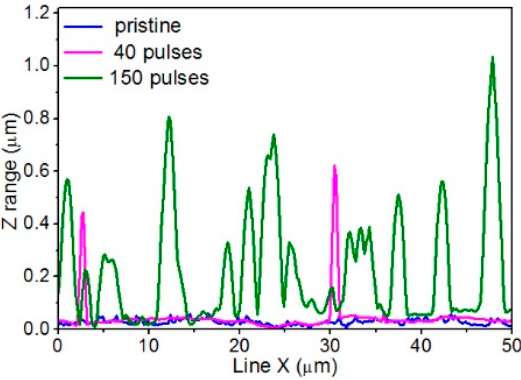
Figure 4. Cross-section profiles obtained from the AFM topographies along the selected line for untreated PEEK and PEEK treated with 40 and 150 EUV pulses, respectively.